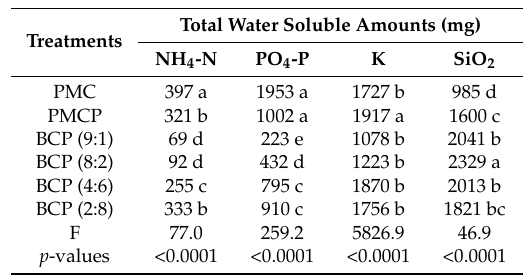
Table 6. Comparisons of total water-soluble accumulated amounts of NH 4 -N, PO 4 -P, K, and SiO 2 for different treatments during leaching